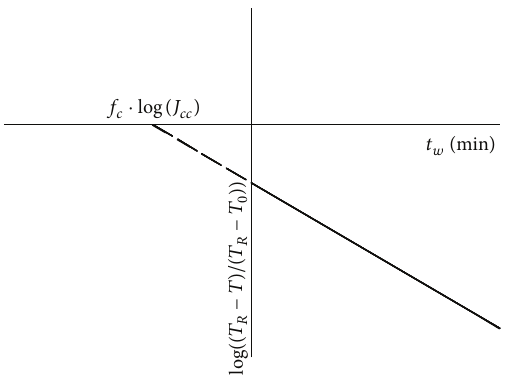
Figure 1: When 𝐽 𝑐𝑐 is less than 1, the time of lag becomes virtually negative in the cooling time scale 𝑡 𝑤 . The dashed line shows the intersection of the cooling exponential curve with the time axis at the negative virtual time: 𝑓 𝑐 ⋅ log (𝐽 𝑐𝑐 ) .